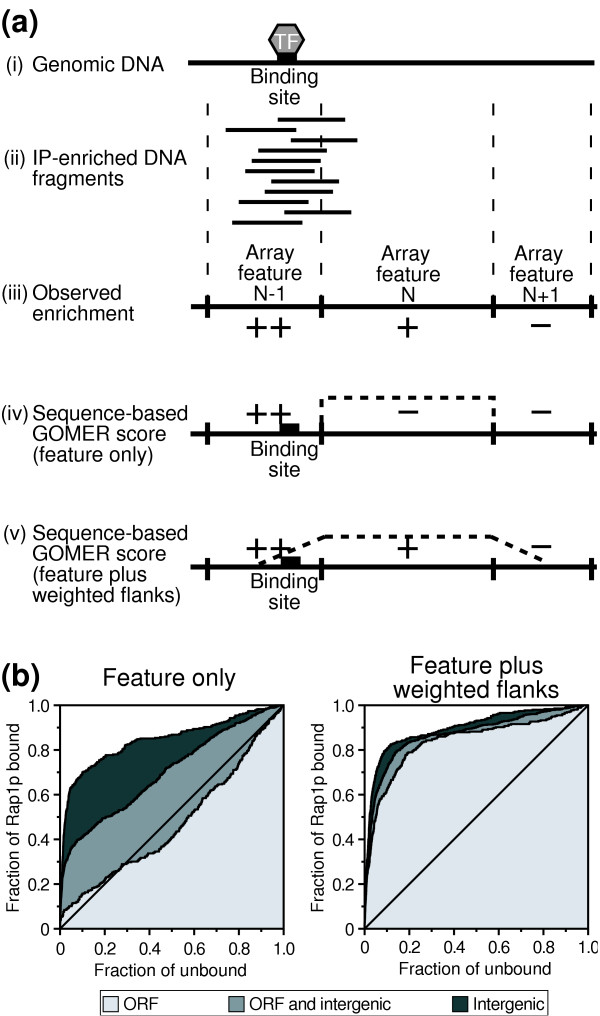
Application of GOMER to chromatin immunoprecipitation microarray experiments. (a) The contribution to array feature enrichment by binding sites outside the sequence of the array feature. (i) A single protein bound to a single high-affinity site (ii) yields a population of enriched DNA molecules averaging approximately 500 base pairs in length. (iii) Hybridization of the enriched sequences to a DNA microarray results in a signal for those array features that overlap the enriched DNA sequences (N-1 and N). (iv) If the sequence of the array features alone is used to predict binding, enrichment of feature N cannot be accurately predicted. (v) Enrichment can be predicted if flanking sequences are included in the calculation. Binding sites outside the array feature sequence are down-weighted as a function of distance from the array feature boundary. (b) Receiver operating characteristic (ROC) curves for Rap1p enriched versus unenriched features, with features ranked by GOMER scores. GOMER scores were calculated using only the features themselves (left) or the features plus weighted flanking sequences (right). ROC curves for different subsets are indicated by shading under the curve: open reading frame (ORF) features only (light gray); both intergenic and ORF features (medium gray); intergenic features only (dark gray).